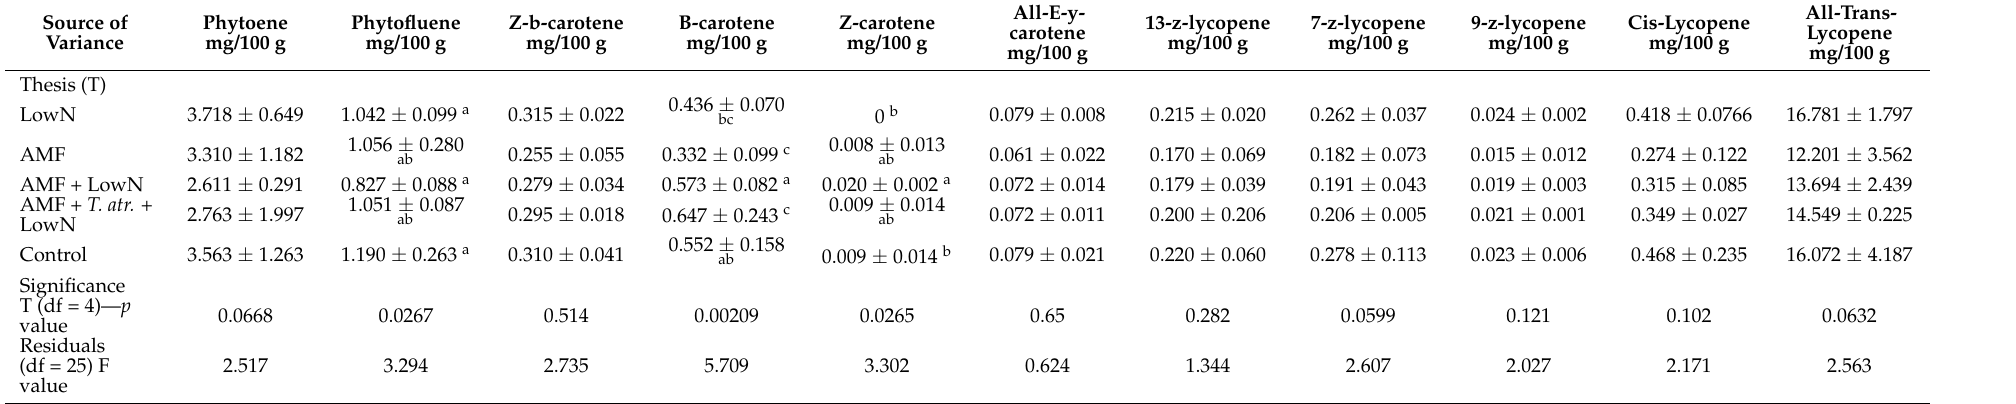
Different letters show significant difference at the 0.05 probability level. Table 4. Carotenoid content in tomato fruits from plants grown under low nitrogen fertilization regimen, treated with different biostimulants at the site with optimal soil fertility. The data were elaborated by one-way analysis and Duncan